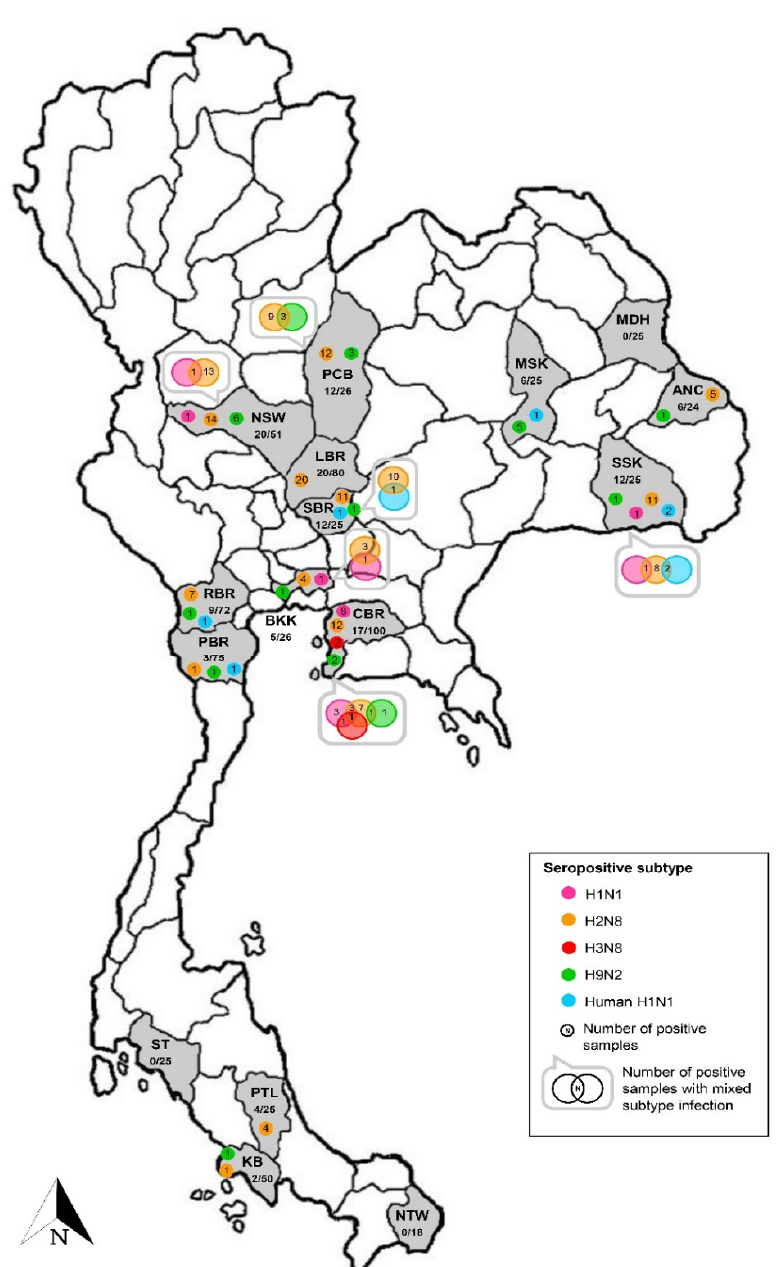
Figure 2. Seropositivity against influenza virus subtypes found in the investigated macaque serum samples. Provinces where the habitat of macaques are shown as abbreviations, including ANC: Am-